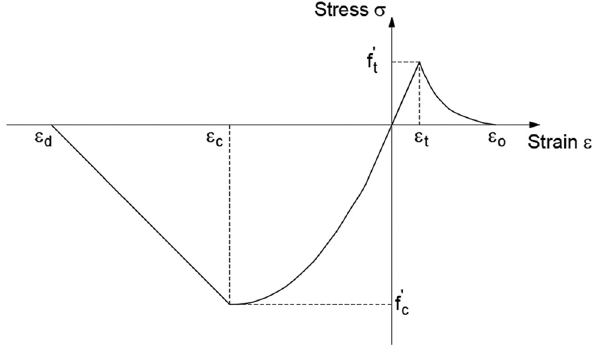
Figure 16: Bond stress – slip relationship between steel bar and concrete [ 36 ]